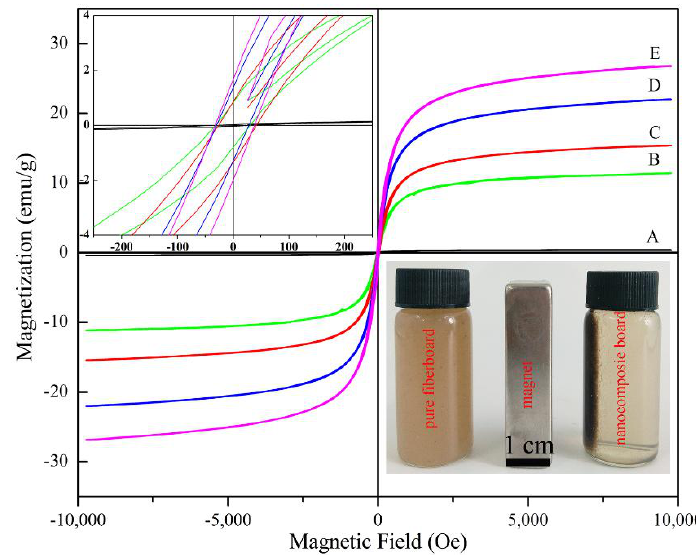
Figure 10. Magnetic hysteresis loops of binderless composite board with different mass fractions. The top left inset shows an enlarged view of the magnetic hysteresis loops. The bottom right inset shows the magnetic response under an external magnetic field. (A. pure fiberboard; B. NFF1 board; C. NFF2 board; D. NFF3 board; E. NFF4 board).